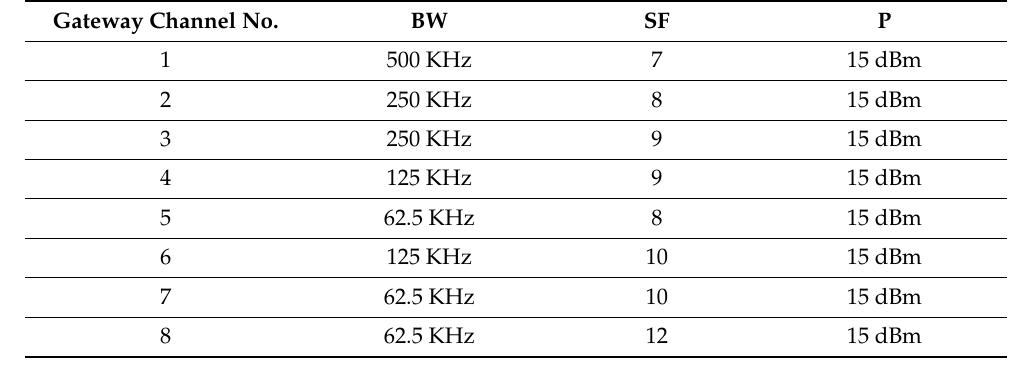
Figure 14. Algorithm comparison.